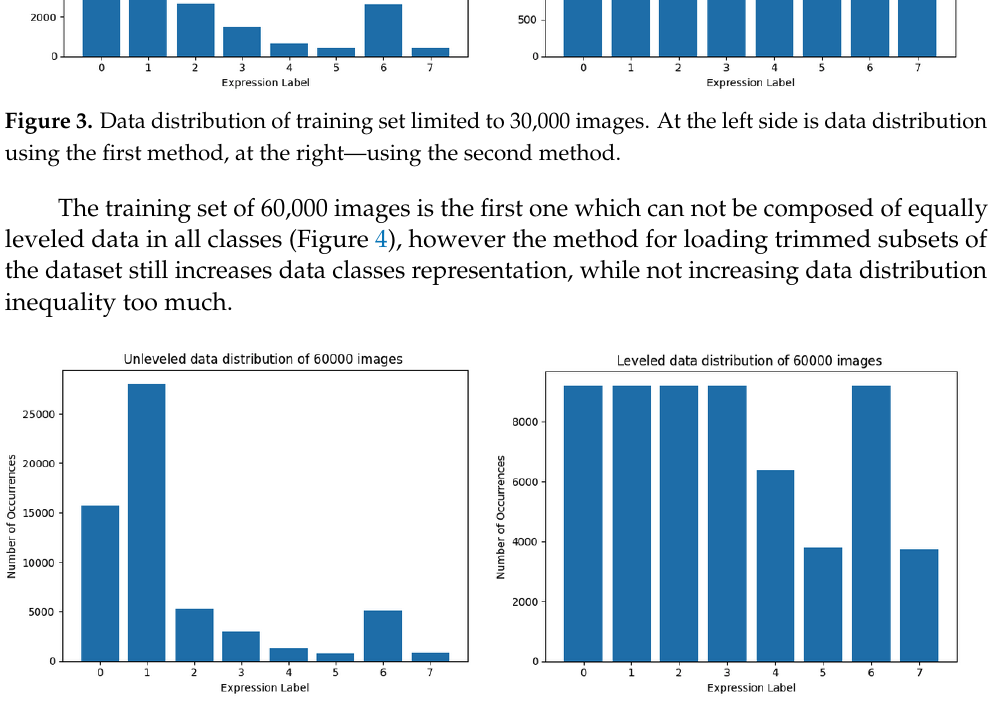
Figure 4. Data distribution of training set limited to 60,000 images. At the left side, the data distribution using the first method is presented, at the right—using the second